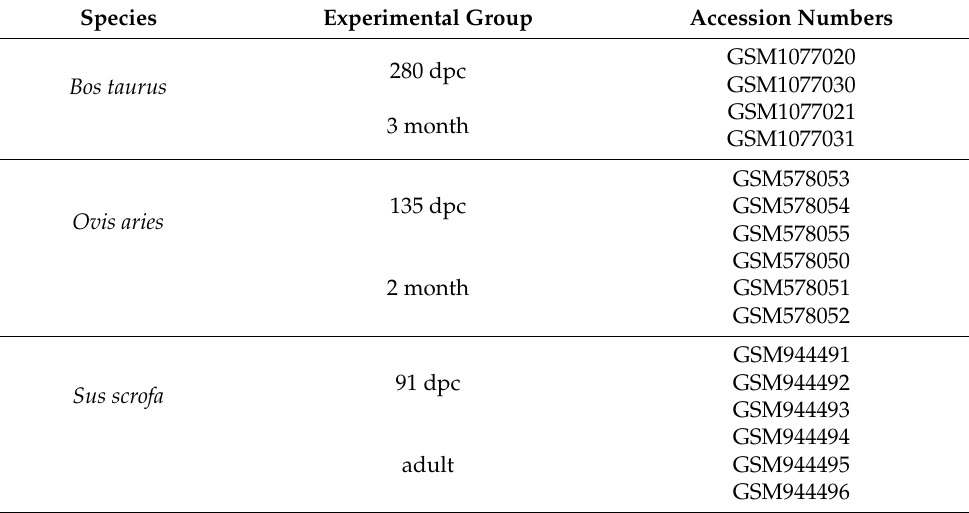
Table 1. Accession numbers of Bos taurus, Ovis aries , and Sus scrofa skeletal muscle tissue expression